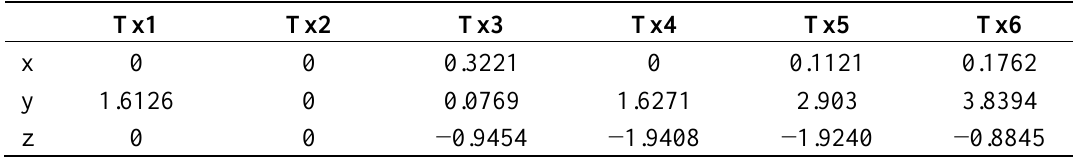
Table 1. Calibrated transmitter positions (in